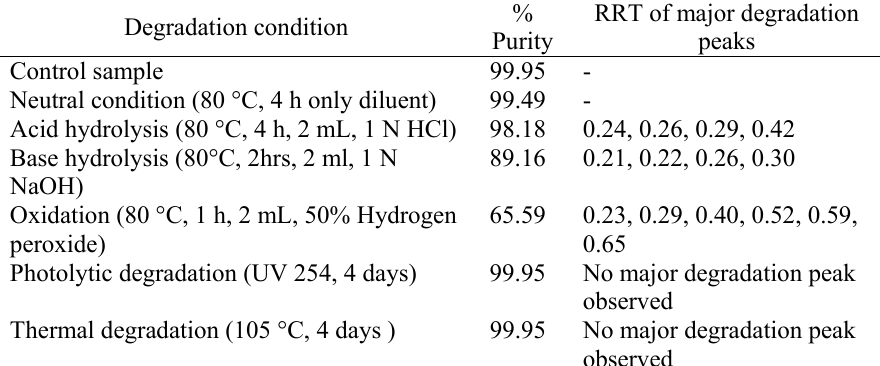
Table 2. Forced degradation study result of